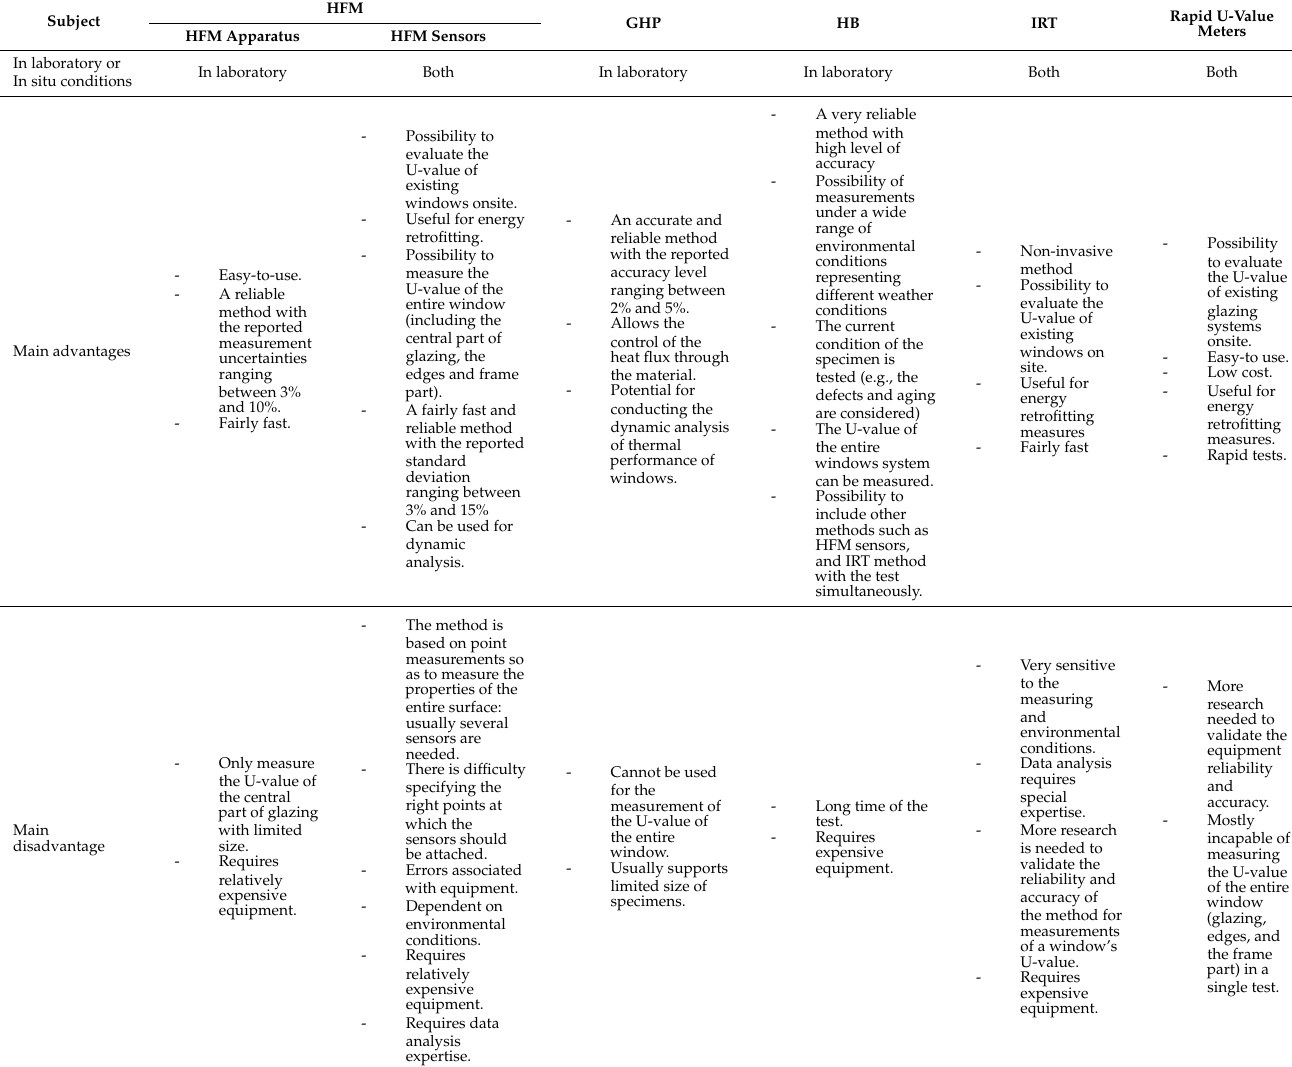
Table 6. Comparison of the reviewed methods for determining the U-value of a